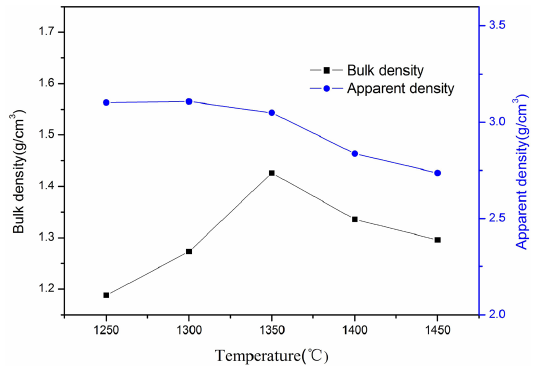
Figure 4. Apparent density and bulk density with sintering